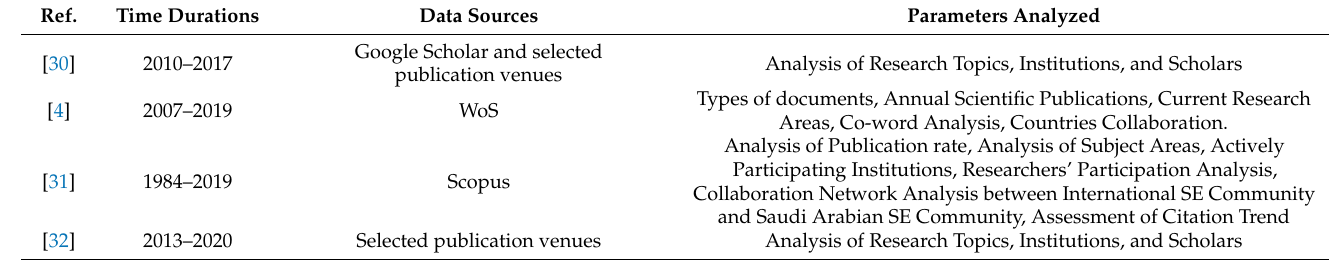
Table 2. The significant contribution of our research